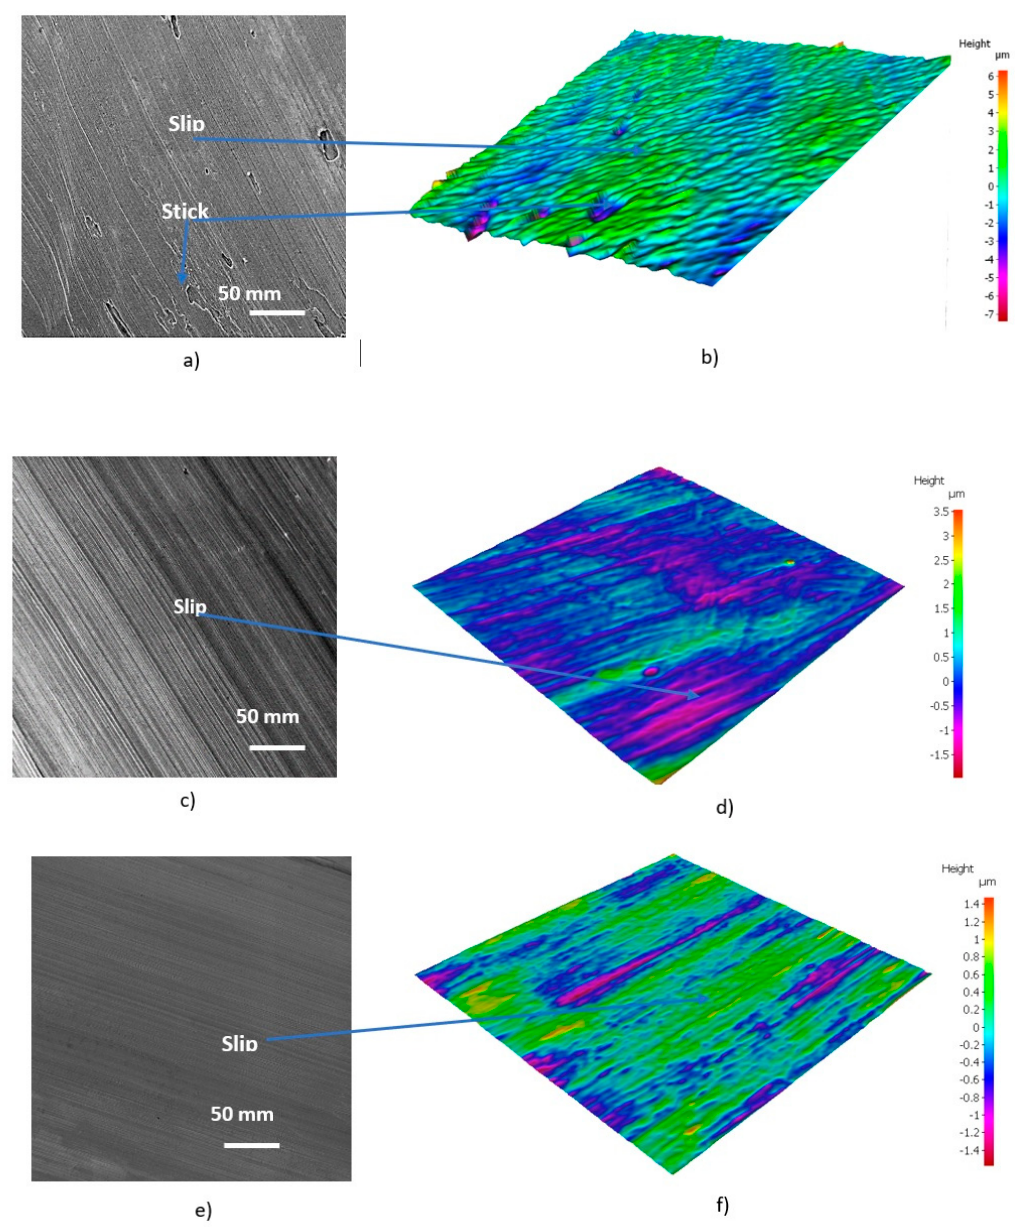
Figure 17. SEM images of chip undersurface combined surface texture obtained by Infinite Focus G5 focus variation microscope (Alicona) with for ( a , b ) uncoated too; ( c , d ) PVD coated tool; ( e , f ) CVD coated tool. Reproduced from [9], with permission from Elsevier, 2020.